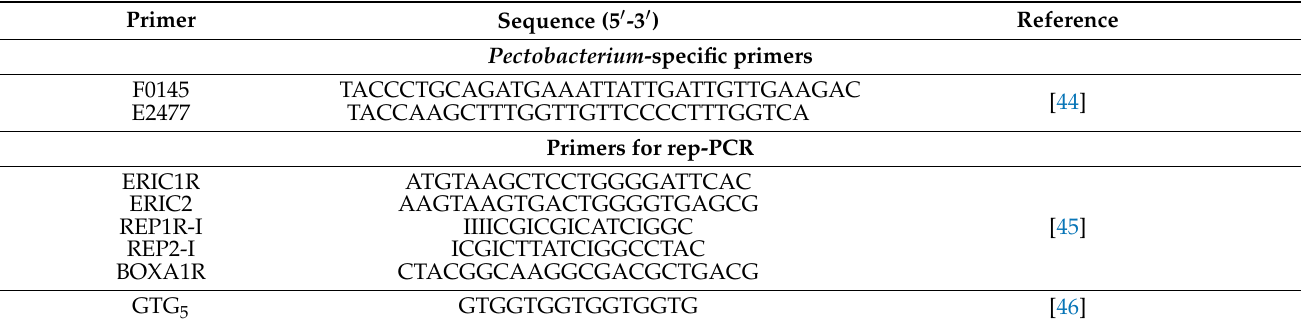
Table 1. Primers used in this